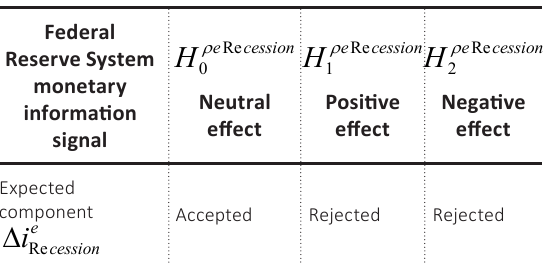
Table 8. Testing results for hypotheses